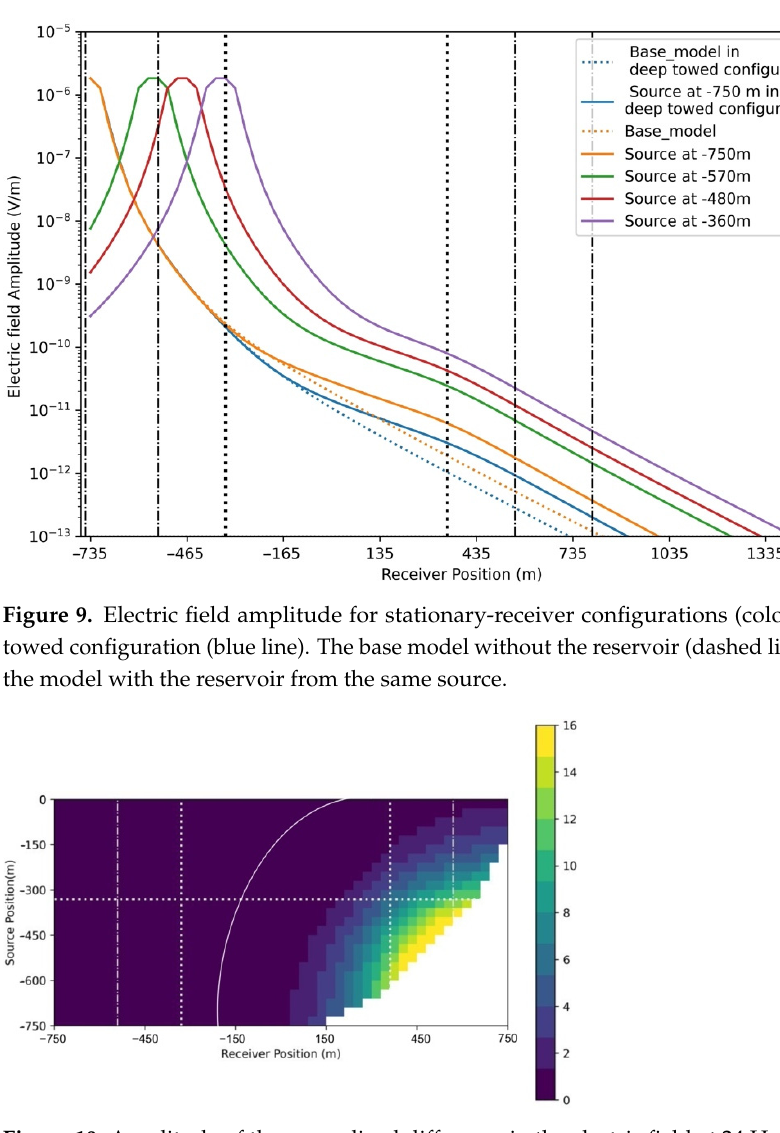
Figure 10. Amplitude of the normalized difference in the electric field at 24 Hz.